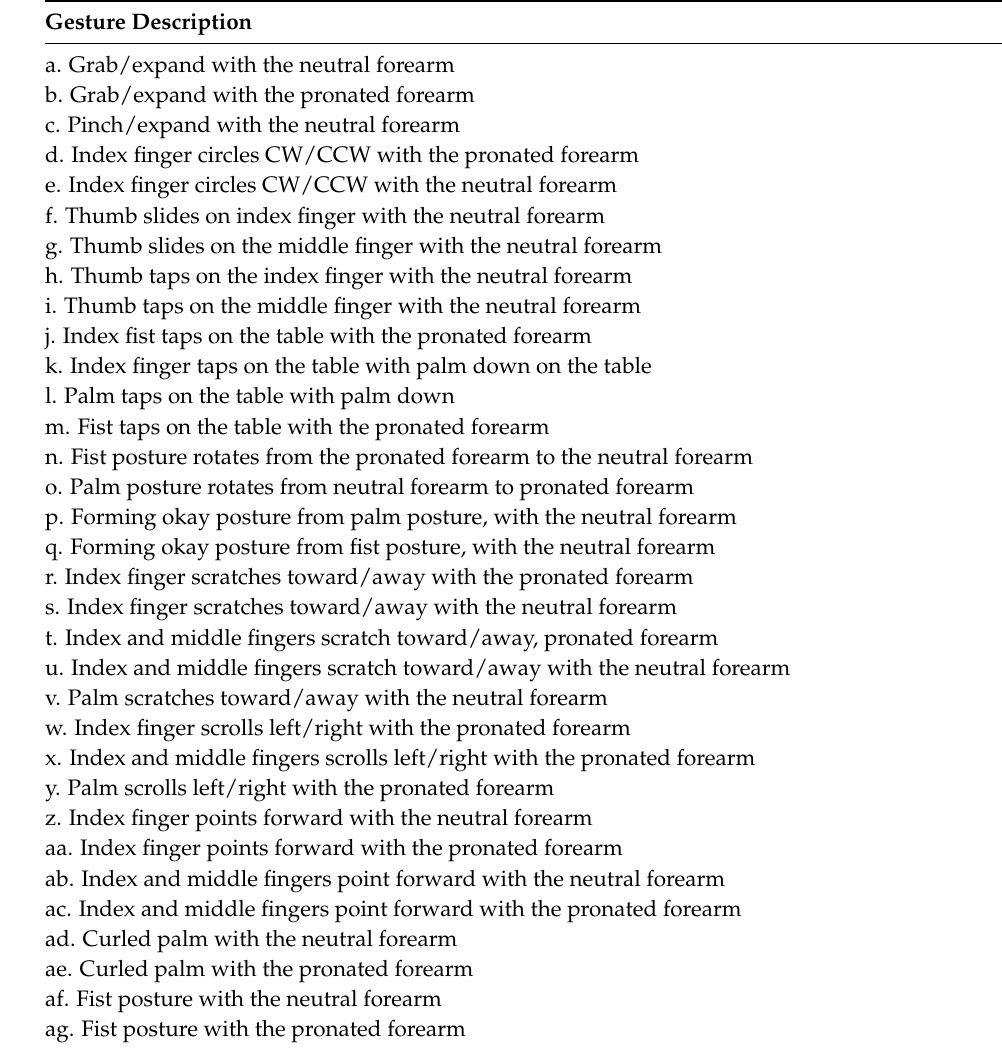
Table 2. The literal description of 33 designed